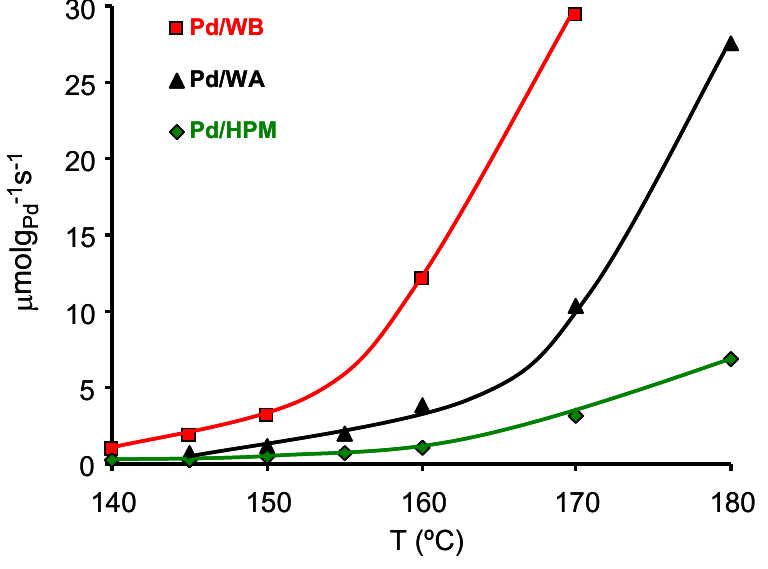
Figure 11. Activity of the catalysts in the m-xylene combustion ( μ mol of m-xylene burned per gram of Pd and per second). From reference [67], with permission of Elsevier.